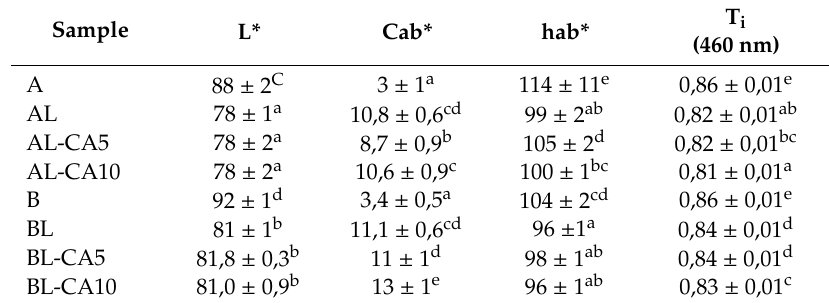
Di ff erent superscript letters within the same column indicate significant di ff erences among films ( p <